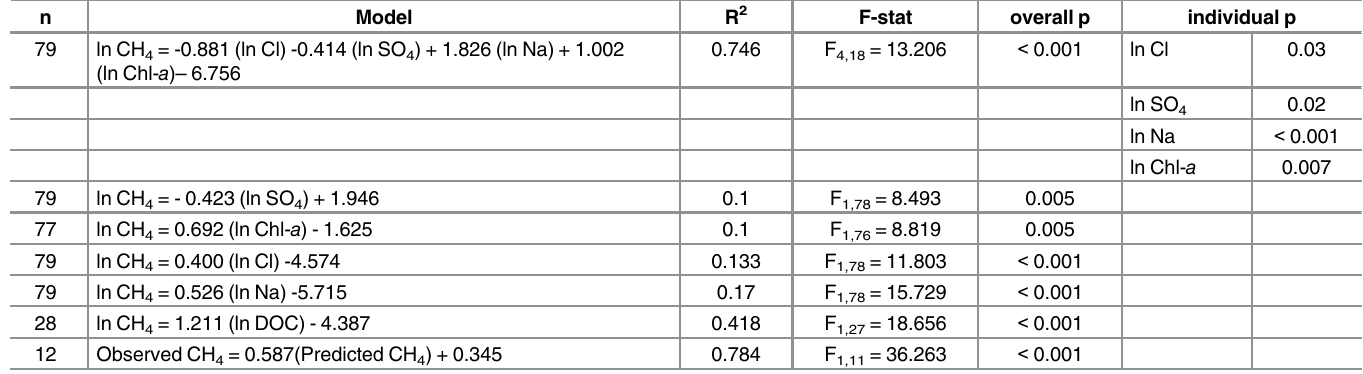
Table 3. Regression results for predicting methane (CH 4 ) in southwest Greenland lakes, along with the validation of this model using 2013 pilot lake data. n Model R 2 F-stat overall p individual